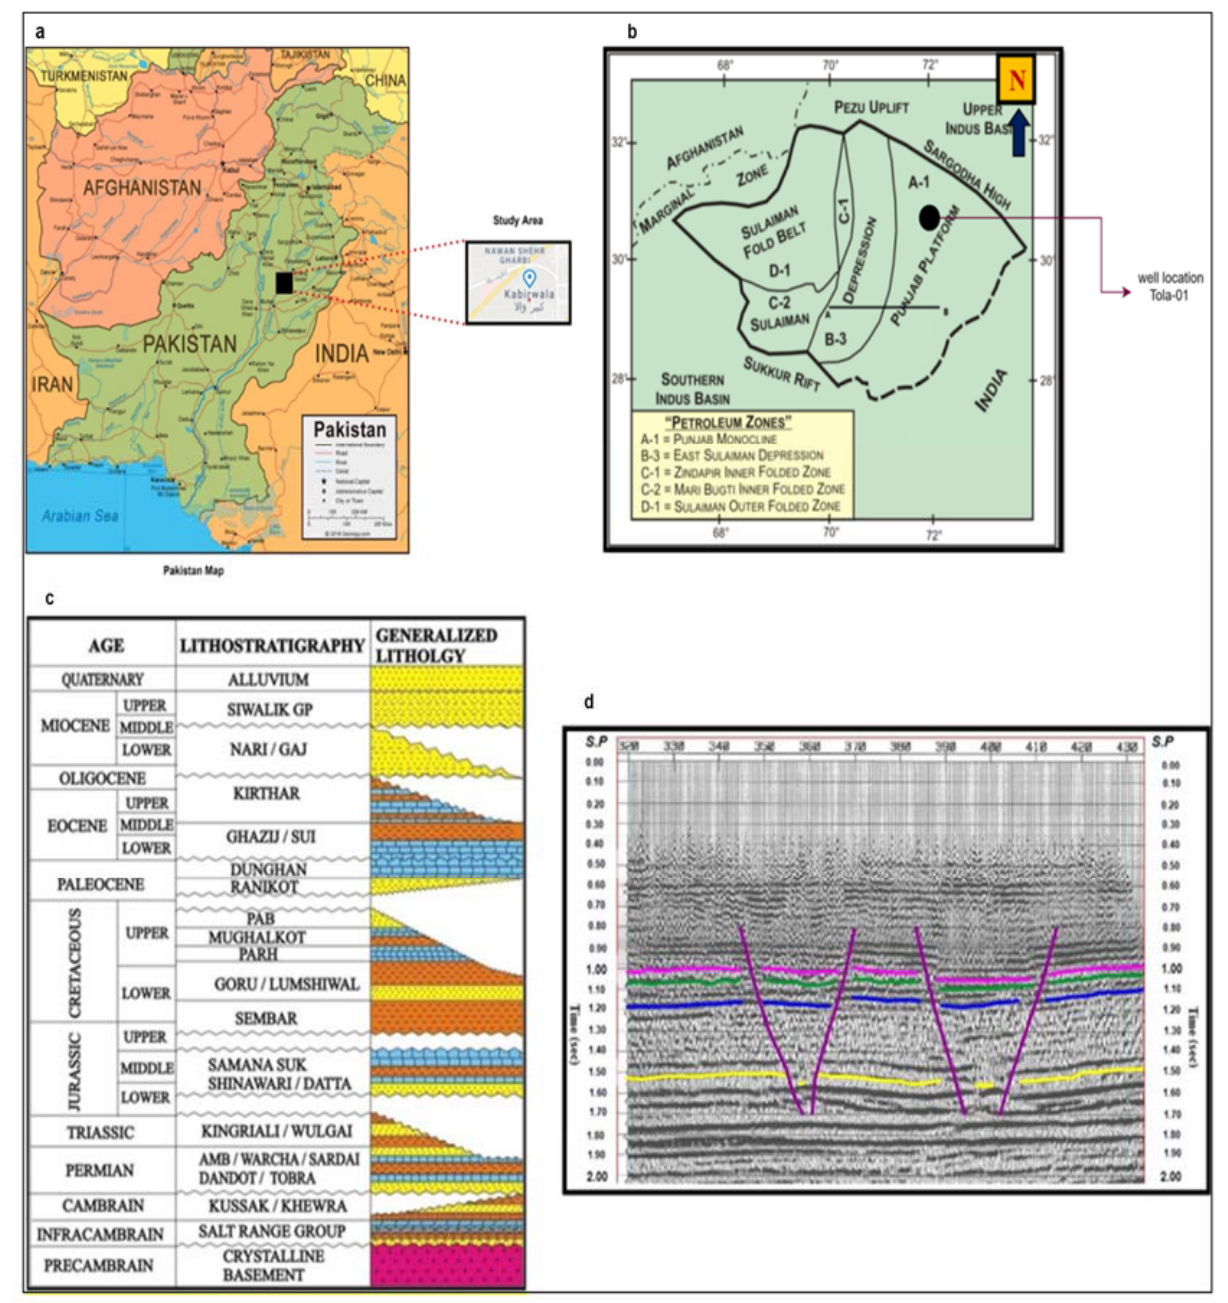
Figure 1. ( a ) Location of the study area. ( b ) Tectonic map of Central Indus Basin and subdivisions of petroleum zones (after [20]). ( c ). Generalized stratigraphic chart of the study area [21]. ( d ). Seismic section with marked horizon.